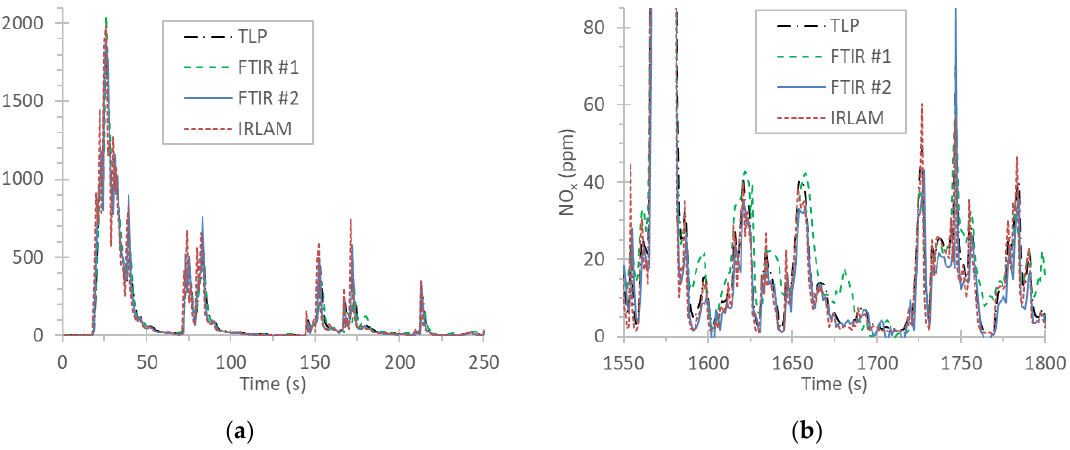
Figure 3. Real time tailpipe concentrations: ( a ) CO over a steady 130 km/h test with regeneration with the Diesel Euro 6 (D6) vehicle; ( b ) Cold start WLTC with the gasoline Euro 6 (G6) vehicle.